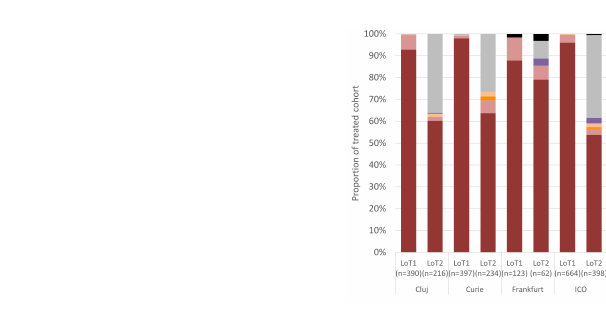
FIGURE 5 Proportion of SACT class received at fi rst and second LoT, by study